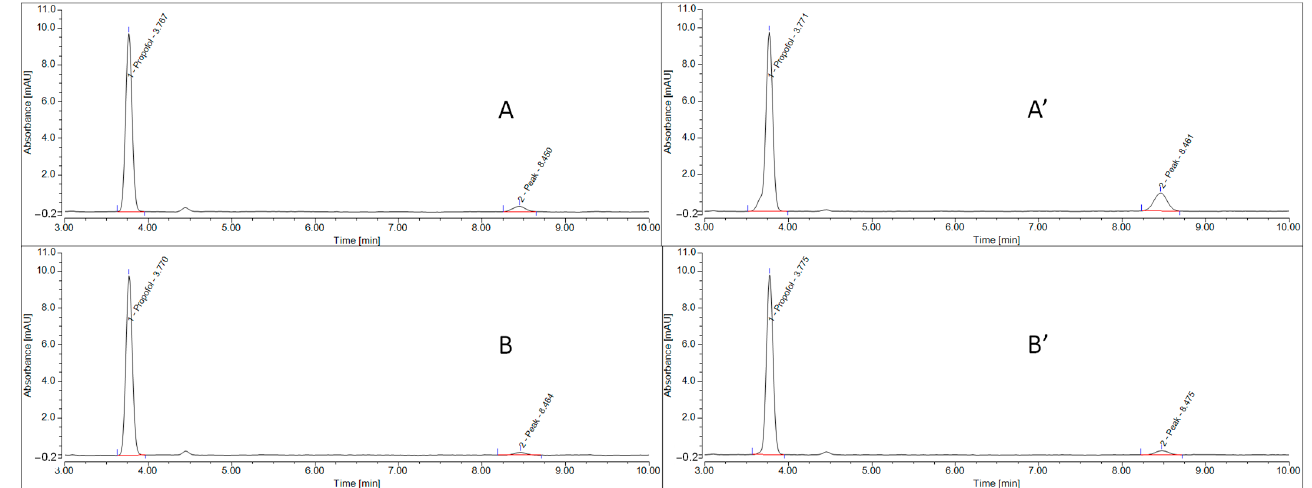
Figure 5. Propofol chromatograms of NE formulations without EDTA before ( A ) and after ( A’ ) heat sterilization and with EDTA before ( B ) and after ( B’ ) heat sterilization.